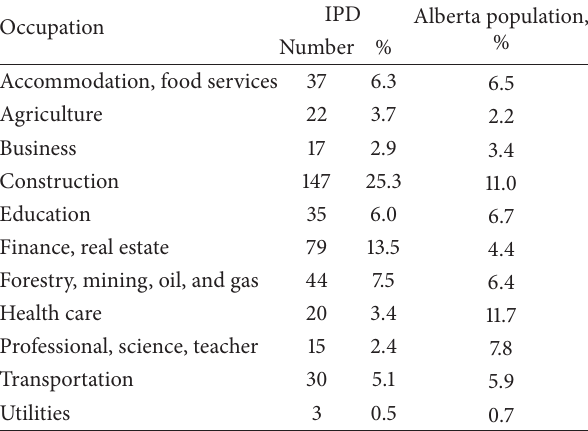
Table 3: Comorbid illnesses in 2435 patients with invasive pneumo- coccal disease.